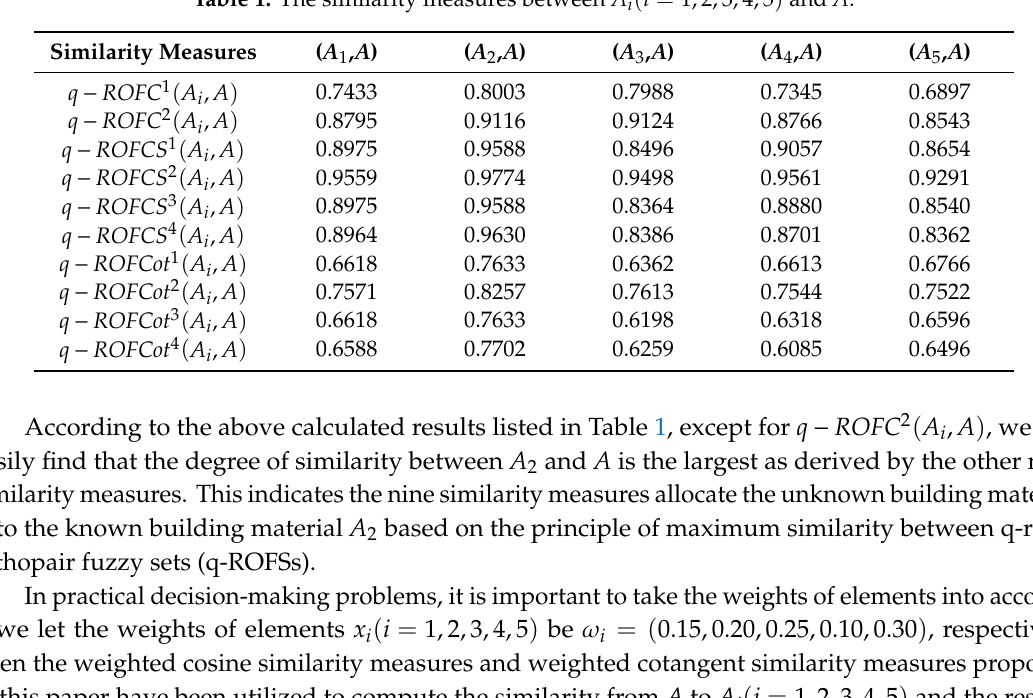
Table 1. The similarity measures between A i ( i = 1,2,3,4,5 ) and A